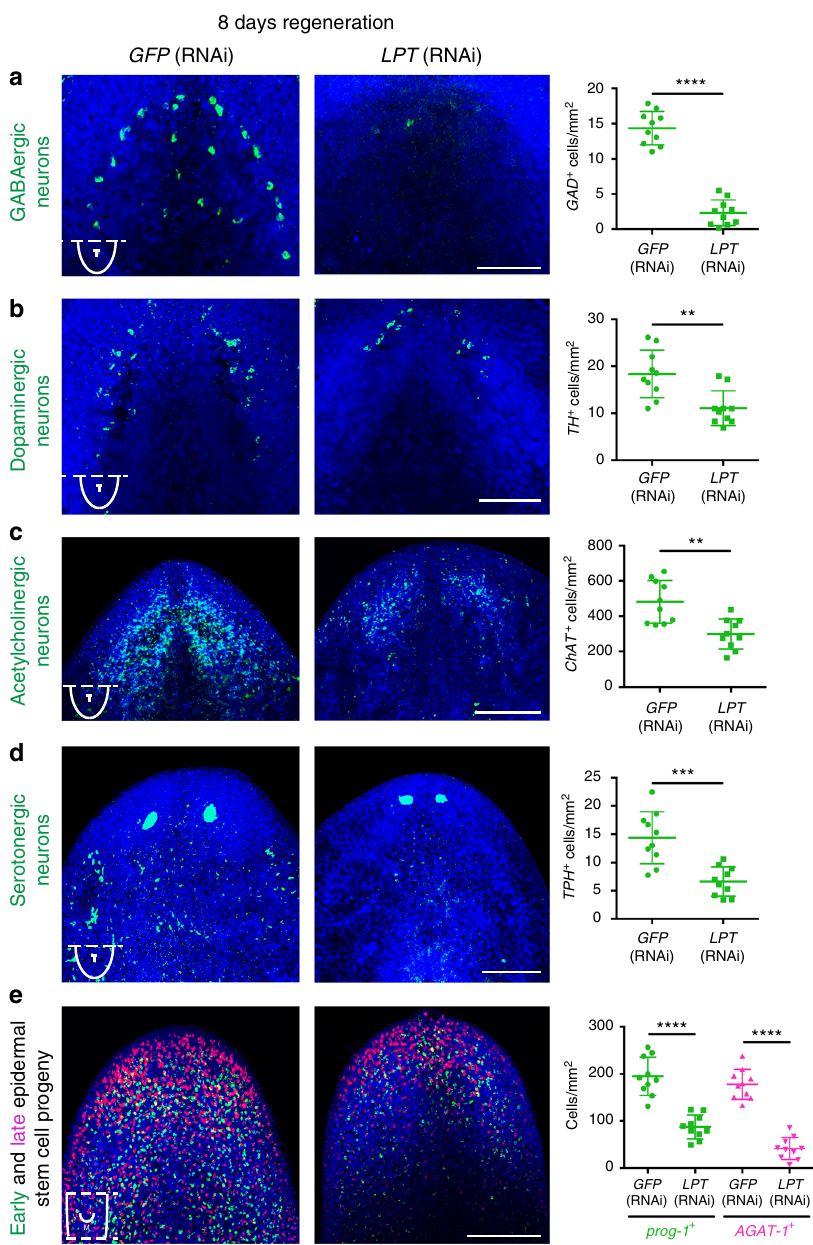
Fig. 3 LPT controls differentiation across neuronal and epidermal lineages. a Quanti fi cation of the number of GABAergic neurons (labeled by GAD ), b dopaminergic neurons (labeled by TH ), c acetylcholinergic neurons (labeled by ChAT ), d serotonergic neurons (labeled by TPH ) and e early (labeled by prog-1 ) and late (labeled by AGAT-1 ) epidermal stem cell progeny at 8 days of regeneration following LPT (RNAi). Two-tailed t -test was used for all comparisons; ** p < 0.005, *** p < 0.0005, **** p < 0.0001. Lines and error bars indicate mean and SD. Five animals per condition per experiment were assessed over the course of two separate experiments. Scale bars: 200 μ